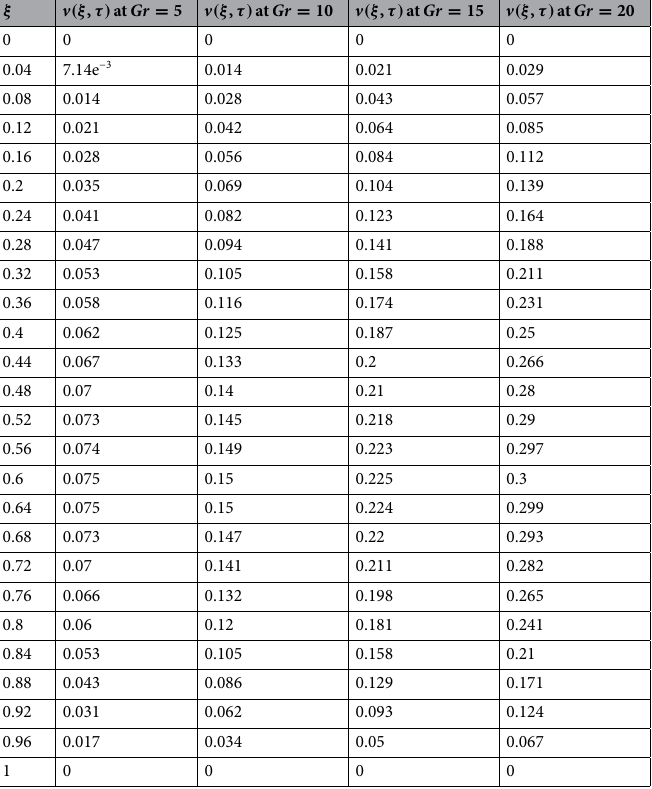
Table 5. Variations in velocity profile against ξ if h (τ) = 0 for different values of Gr .